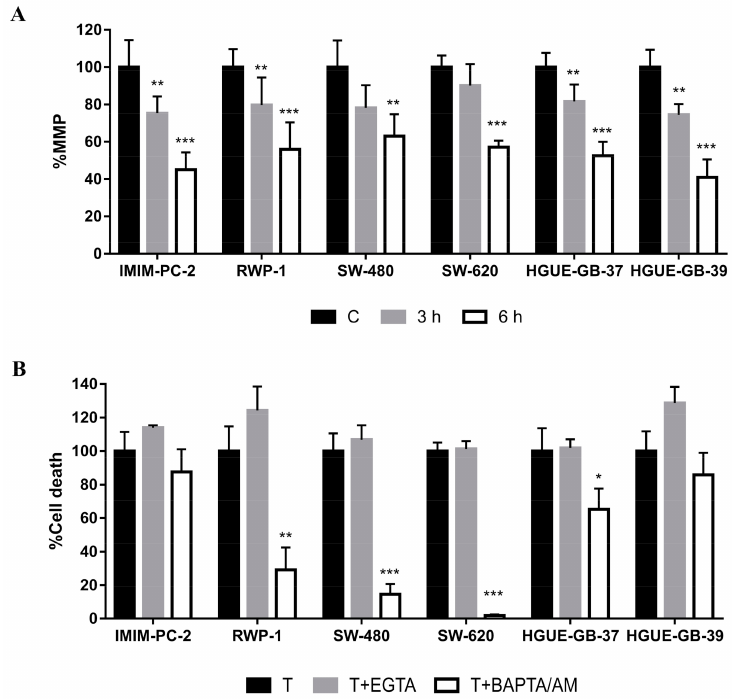
Figure 1. Role of mitochondrial membrane potential (MMP) and calcium in CLytA-DAAO-induced cell death. ( A ) IMIM-PC-2, RWP-1, SW-480, SW-620, HGUE-GB-37 and HGUE-GB-39 cell lines were treated with CLytA-DAAO and D-Ala for 3 or 6 h and the MMP was determined using MitroTracker Green FM and MitoTracker Red CMXRos fluorescent dyes. Data represent the percentage of MMP, normalized with the control cells (Cs) as 100% ± SD with n ≥ 6. ( B ) IMIM-PC-2, RWP-1, SW-480, SW-620, HGUE-GB-37 and HGUE-GB-39 cell lines were treated with CLytA-DAAO and D-Ala (T) in the presence or absence of BAPTA / AM or EGTA as described in the materials and methods section and cell death was determined by flow cytometry. Data represent the percentage of cell death, normalizing the treatment with CLytA-DAAO as 100% ± SD with n ≥ 3. * indicates a p -value < 0.05, ** p -value < 0.01 and *** p -value <